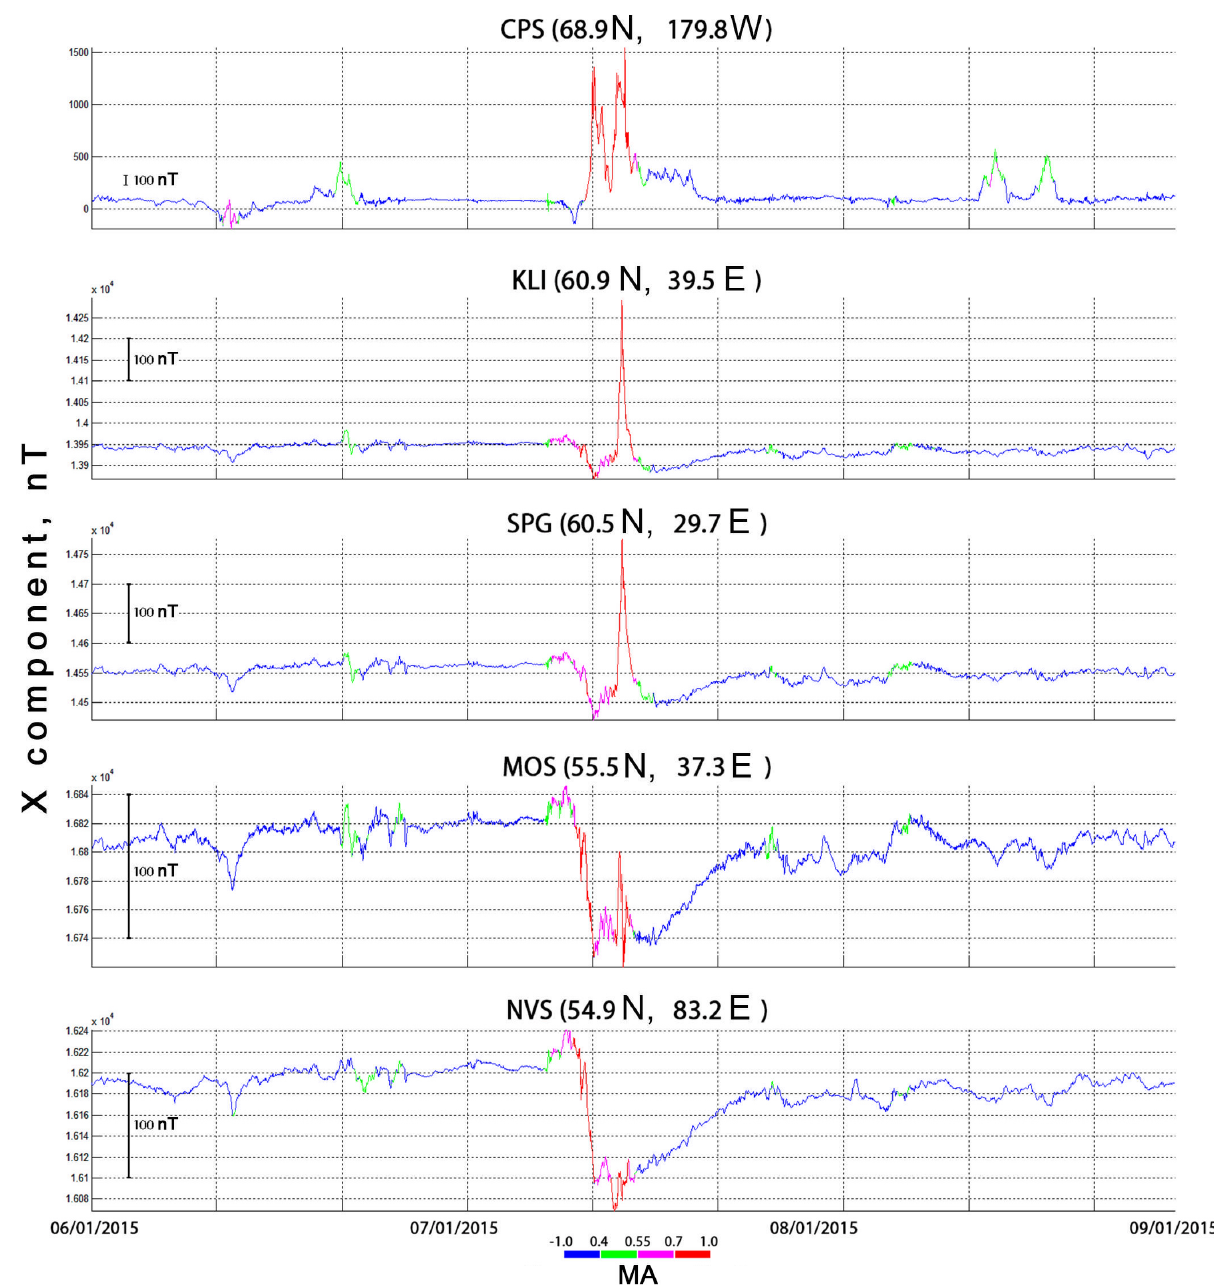
Figure 7. Recognition of geomagnetic activity before, during and after magnetic storm of January 7, 2015, using data of selected Russian geomagnetic observatories. Date format: